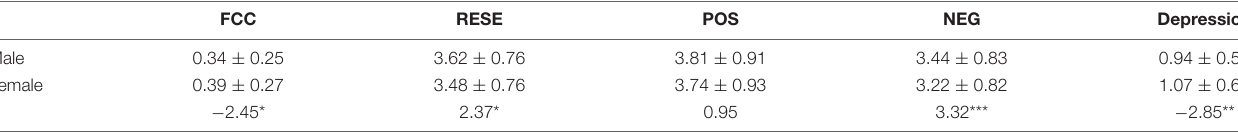
TABLE 1 | T -testing of scores between males and females on the main study variables ( N = 654).